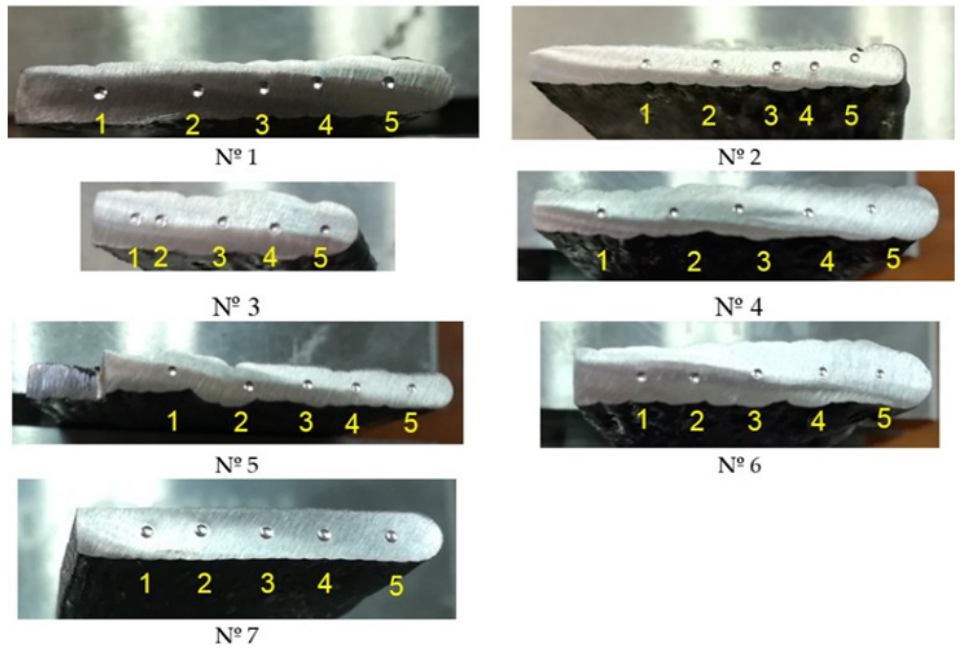
Figure 5. Brinell hardness tests applied to WAAM samples and identification of indentation